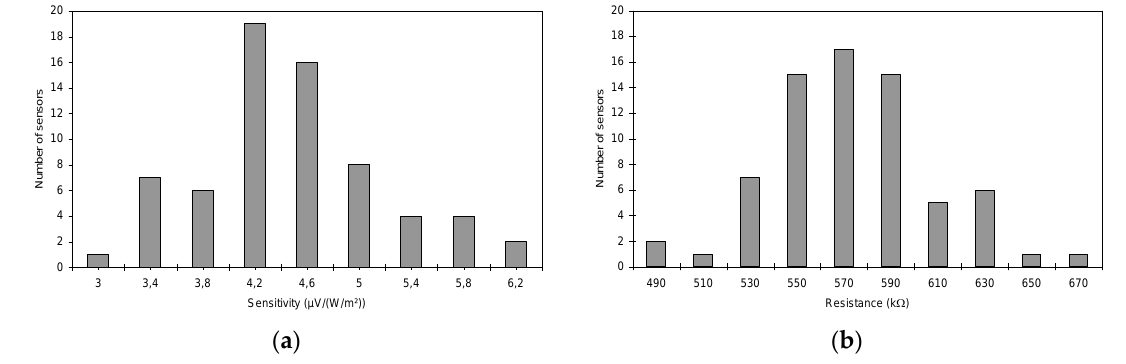
Figure 6. Dispersion histograms of ( a ) sensitivities; and ( b ) resistances.